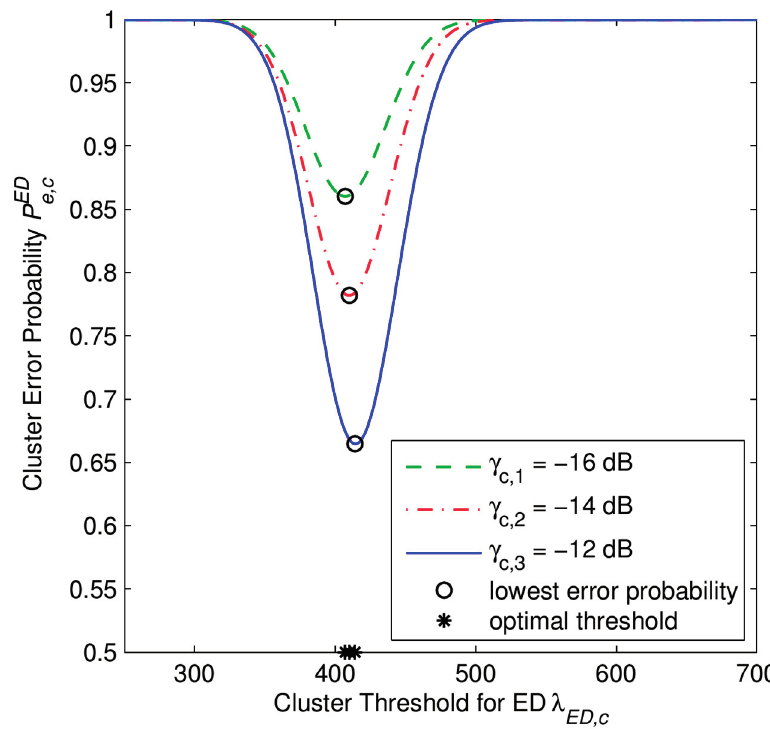
Figure 5. Derivation of the optimal cluster threshold in the case of using the Energy Detector (ED). The error probability at a cluster head P 1 = P 0 = 0.5, M = 50 samples, N = 4 SUs.